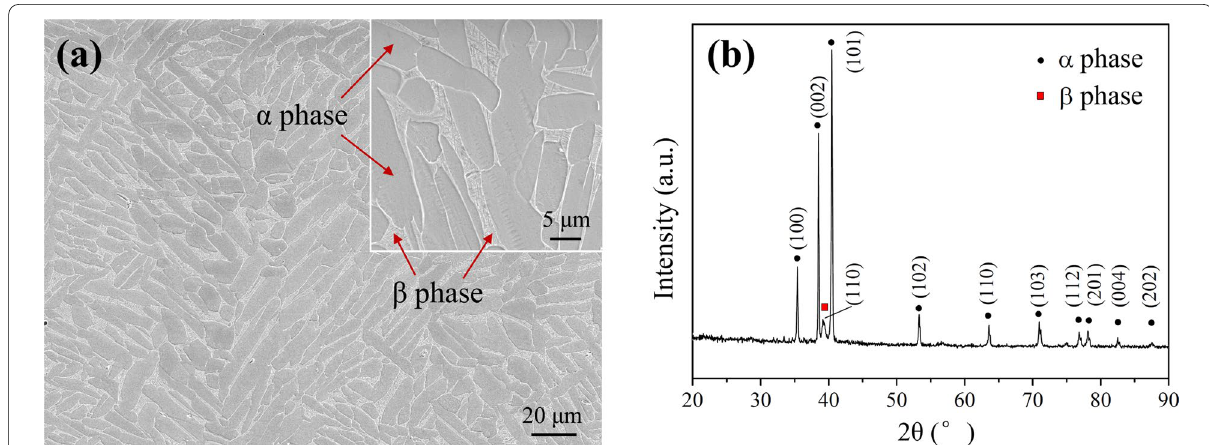
Figure 3 SLM-built Ti6Al4V alloy: a microstructure and b phase constitution of the SLM-built Ti6Al4V alloy after heat treatment at 955 °C